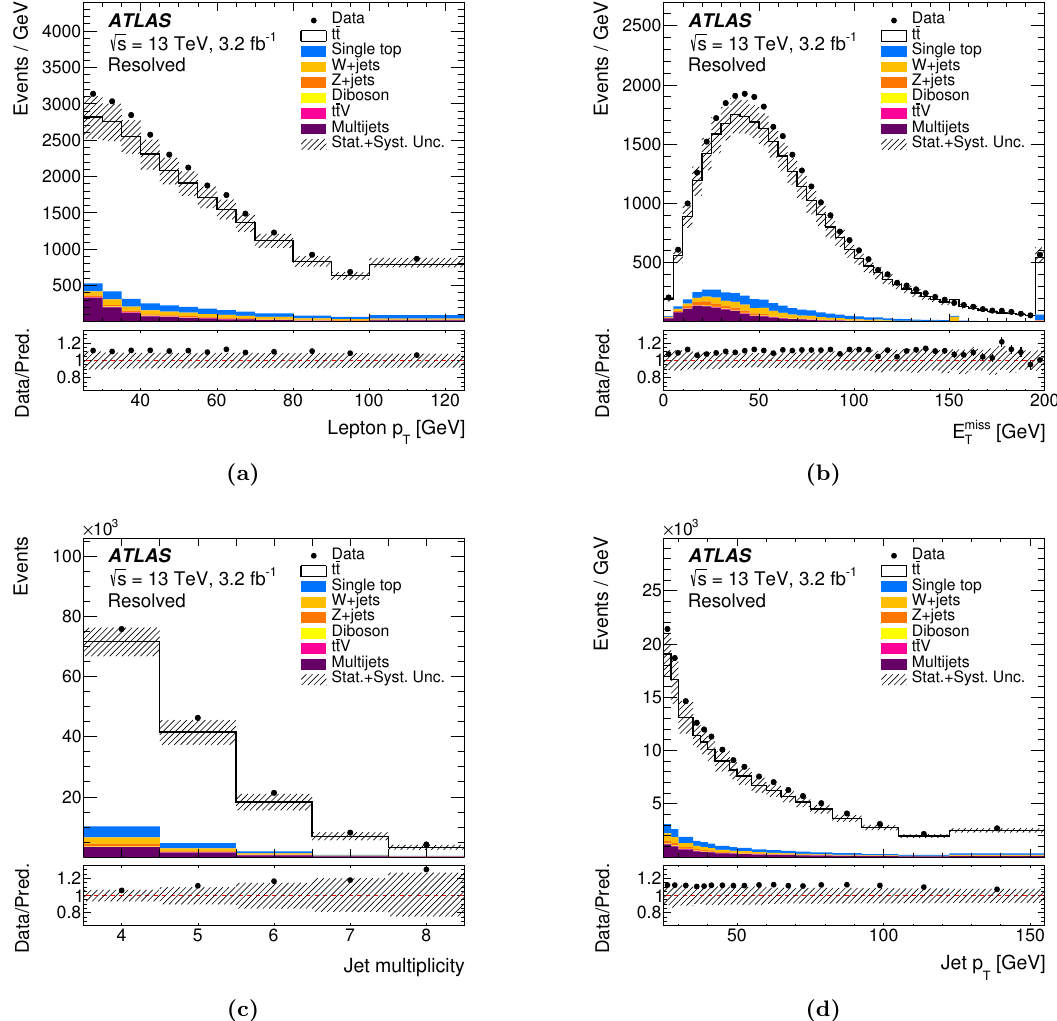
Figure 1. Kinematic distributions in the combined ‘ +jets channel in the resolved topology at de- tector level: (a) lepton transverse momentum and (b) missing transverse momentum E miss multiplicity and (d) transverse momenta of selected jets. Data distributions are compared to pre- dictions using Powheg + Pythia6 as the t (cid:22) t signal model. The hatched area indicates the combined statistical and systematic uncertainties in the total prediction, excluding systematic uncertainties related to the modelling of the t (cid:22) t system. Events beyond the range of the horizontal axis are included in the last bin.